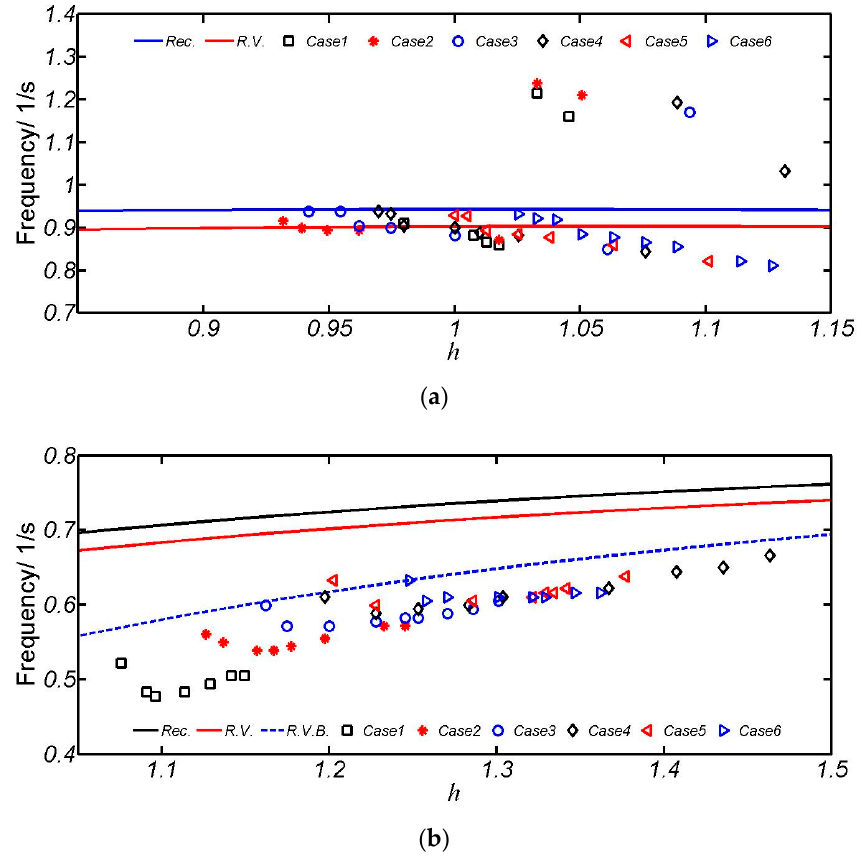
Figure 8. ( a ) Oscillating frequencies vs. water levels in the tank (for region 1); ( b ) Oscillating frequencies vs. water levels in the tank (for region